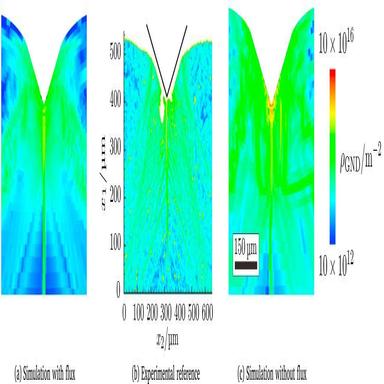
Geometrically Necessary Dislocation (GND) density GND on a logarithmic scale as experimentally obtained by Kysar et al. in comparison to the simulation results. Figure adopted from with permission from Elsevier.